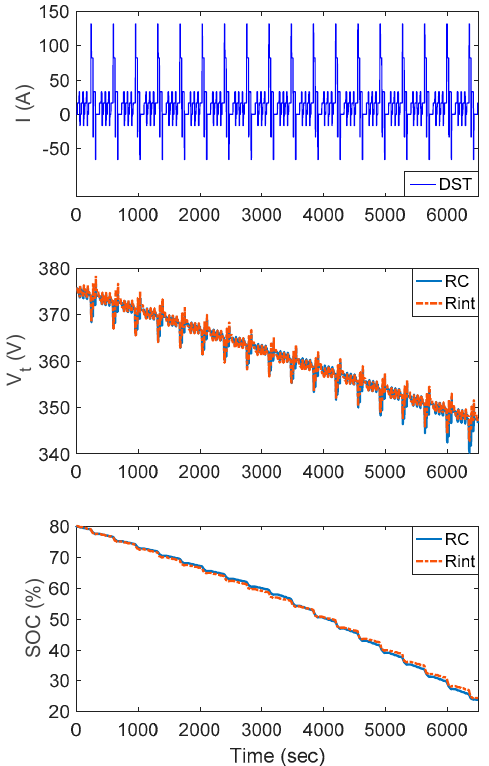
Figure 10. SOC responses between RC and Rint models for 18 consecutive DST.